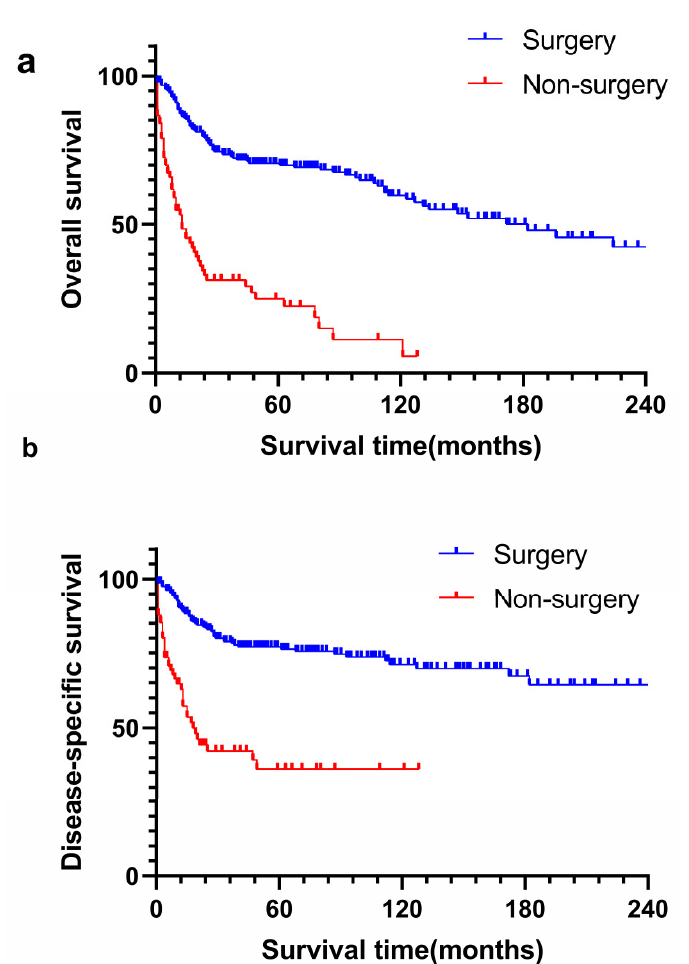
Figure 2. The overall survival (OS, ( a ), p < 0.001) and disease-specific survival (DSS, ( b ), p < 0.001) analyses for primary bile duct and ampullary neuroendocrine neoplasms patients in surgery and non-surgery subgroups.